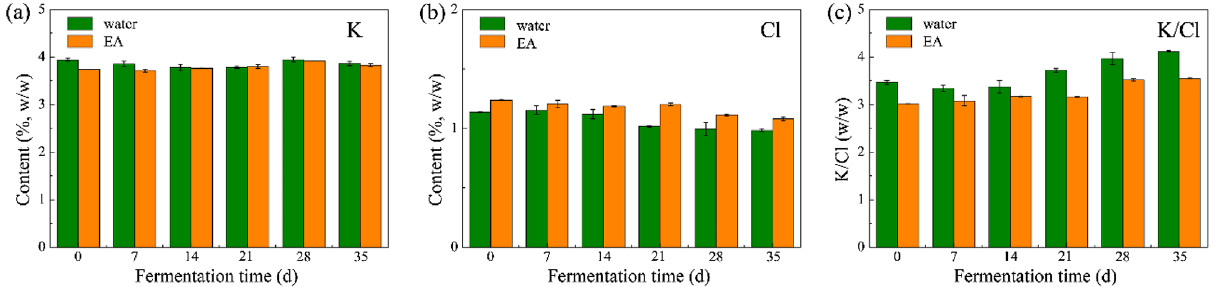
Figure 2. Contents of K ( a ), Cl ( b ), and K/Cl values ( c ) of CTL samples in water- and EA-groups.